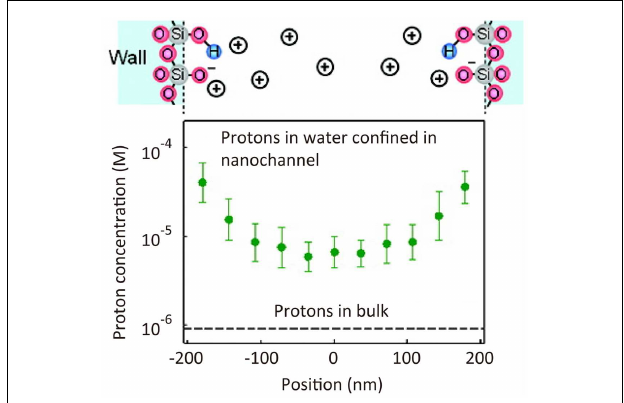
FIGURE 7 | Super-resolution imaging of proton concentration in a nanochannel. pH profile in a 410nm width nanochannel determined by the spatial intensity map of fluorescence intensity of fluorescein dye (Kazoe et al., 2011). Reproduced with permission from Kazoe et al. (2011), copyright 2011, American Chemical